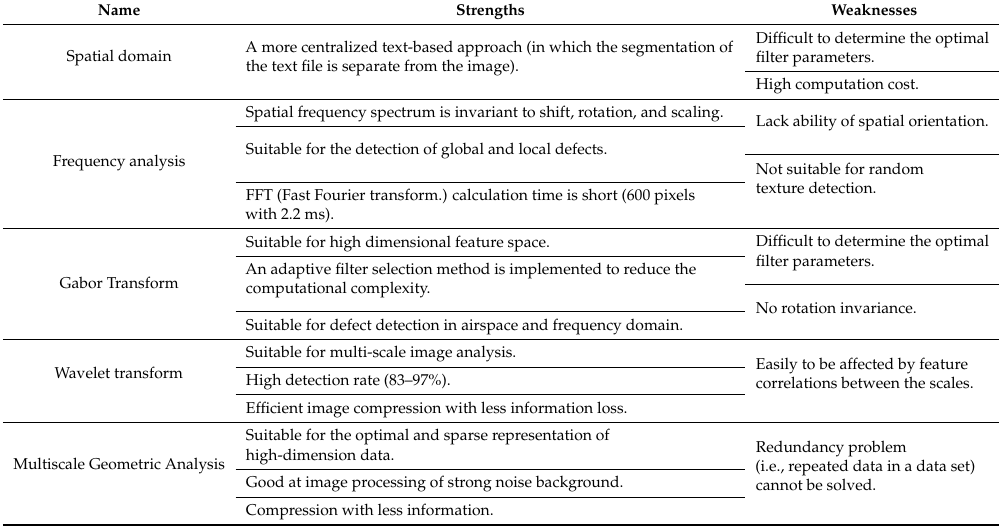
Table 3. Strengths and weaknesses of filtering-based detection methods for steel